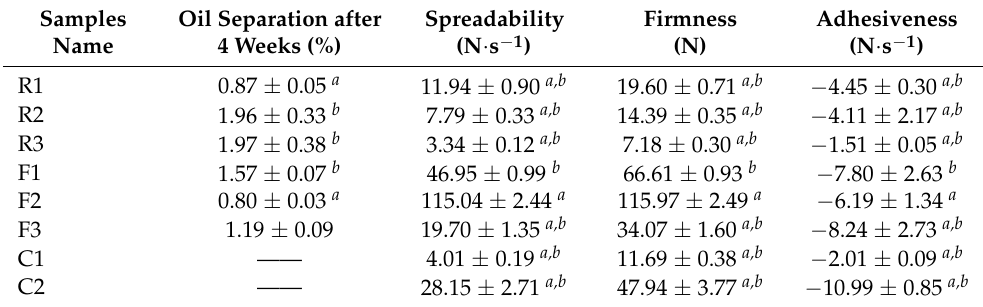
Table 3. Texture analysis and oil separation (Mean ± SD) of stored peanut